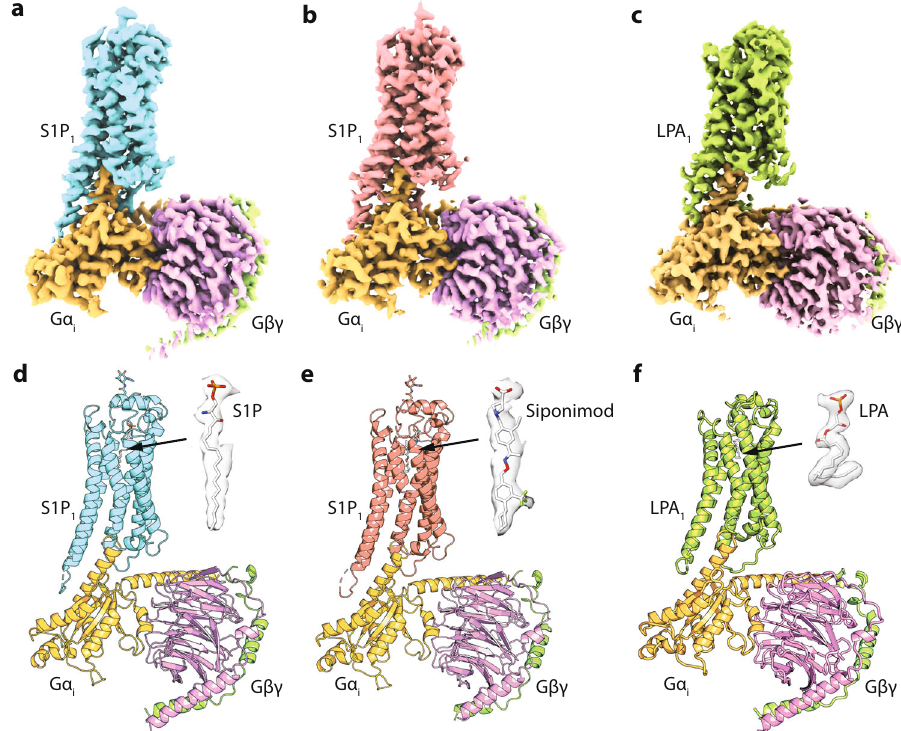
Fig. 1 Cryo-EM structures of the S1P – S1P 1 – G i complex, the Siponimod – S1P 1 – G i complex, and the LPA – LPA 1 – G i complex. a – c The three-dimensional density maps of the complexes. d – f Cartoon presentations of the three complex structures with S1P, Siponimod, or LPA shown in spheres inside the orthosteric pockets, as well as their density maps on the sides. S1P 1 is colored in cyan or salmon, LPA 1 in green, G α i in orange, G β in purple, and G γ in light